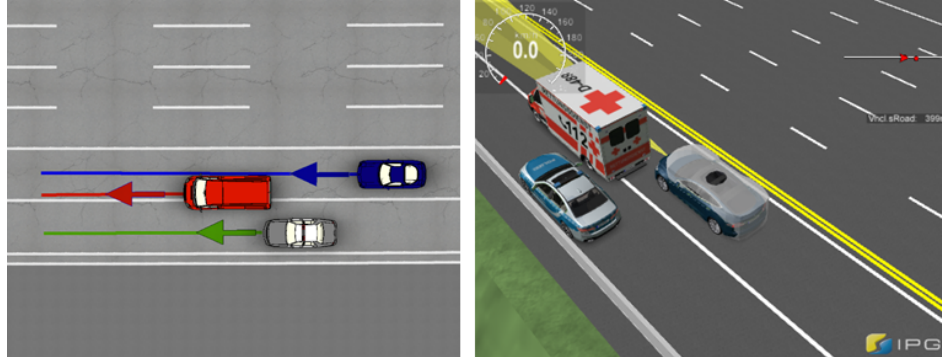
Figure 5. The visualization of the collision simulation of Tesla S and Fire